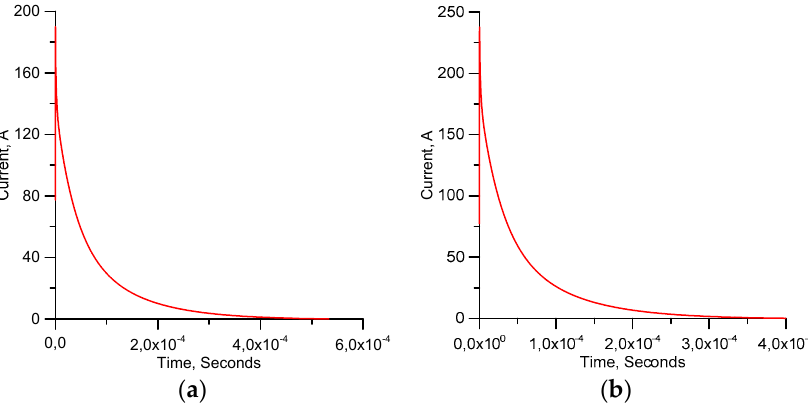
Figure 3. ( a ) The current generated at ground level by the mini-lightning return stroke traveling with a speed of 1.0 × 10 8 m/s along the macro channel. ( b ) Same as in ( a ) except that the speed of propagation is 1.5 × 10 8 m/s.